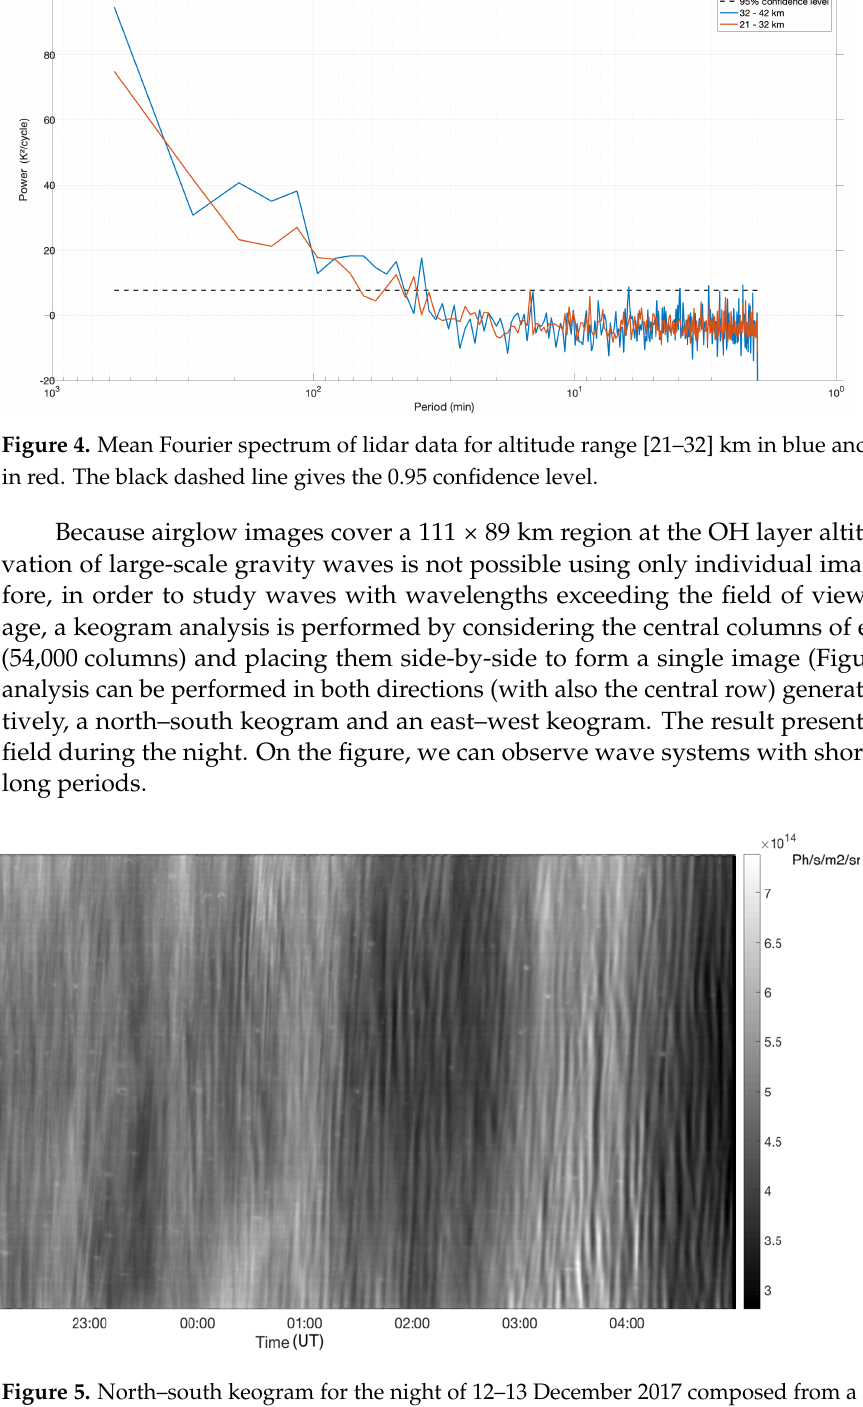
Figure 5. North–south keogram for the night of 12–13 December 2017 composed from a series of OH images. The grey scale is in ph/s/m 2